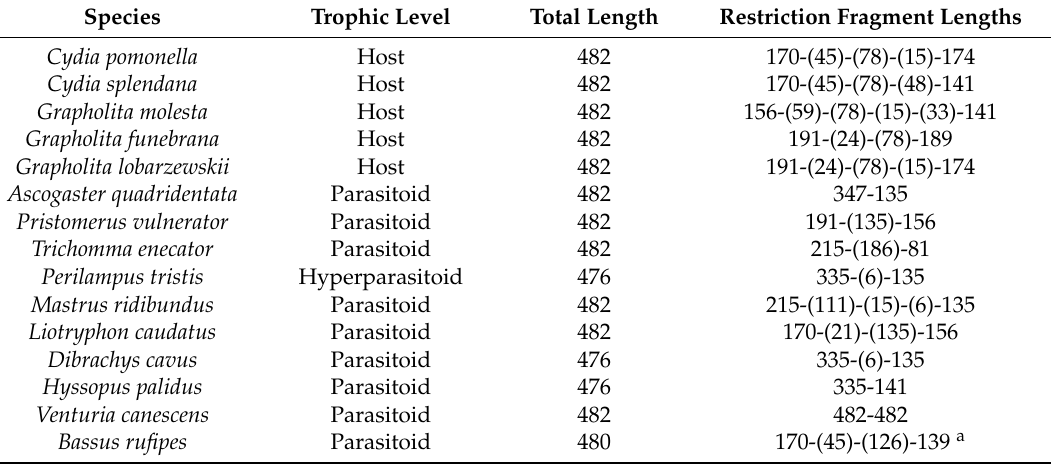
Table 1. DNA lengths (in bp) for each parasitoid and host species resulting from the PCR-RFLP in the COI mitochondrial gene. Restriction fragment lengths were ranged according to their position along the COI sequence. The PCR-RFLP diagnosis of the parasitoids and their tortricid hosts was based on the lengths of the two external fragments, which were labeled with different dyes attached to the forward and reverse PCR primers. Undetected restriction fragments are provided in